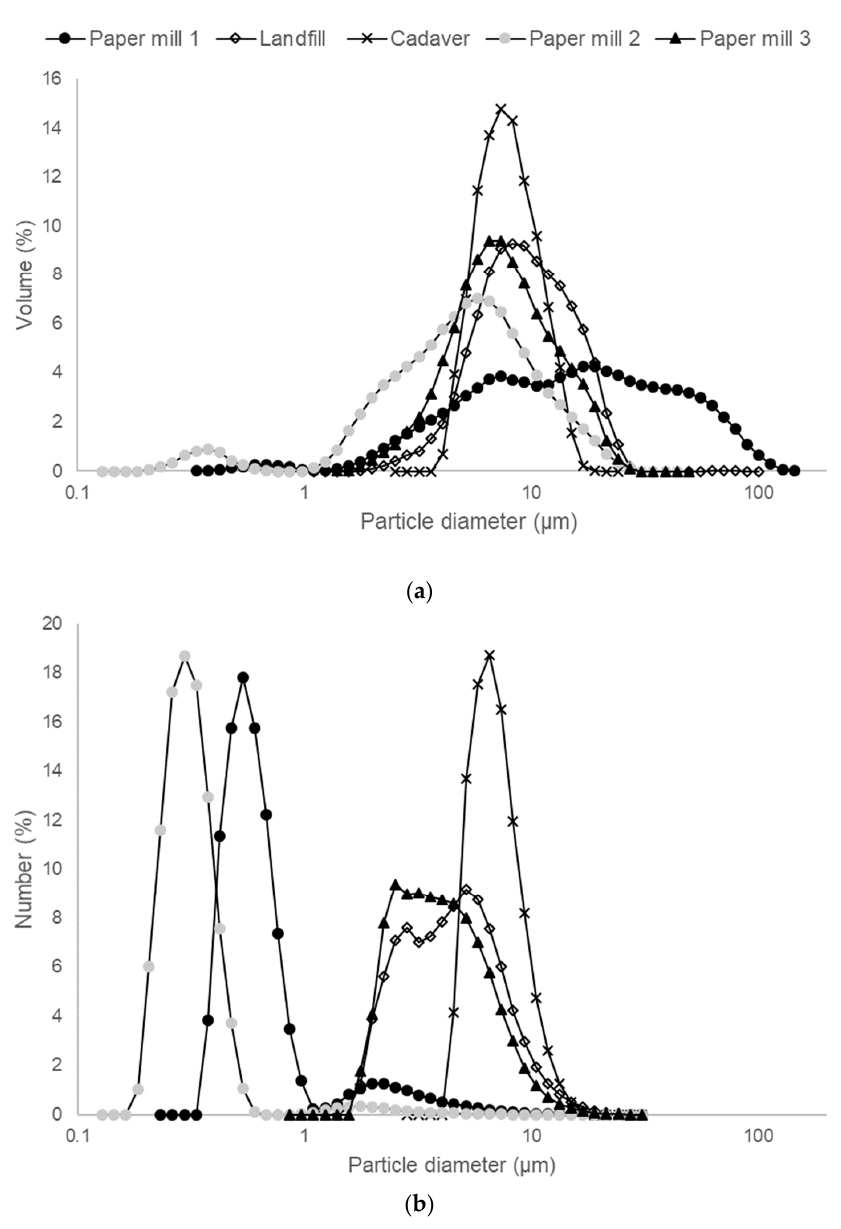
Figure 5. Volumetric ( a ) and numeric ( b ) based particle size distribution of Paper mill 1 ( ● ); Land fi ll ( ◊ ); Cadaver (×); Paper mill 2 ( ● ); Paper mill 3 ( ▲ ). Average maximum error is 0.21% (for volumetric) and 0.51% (for numeric).